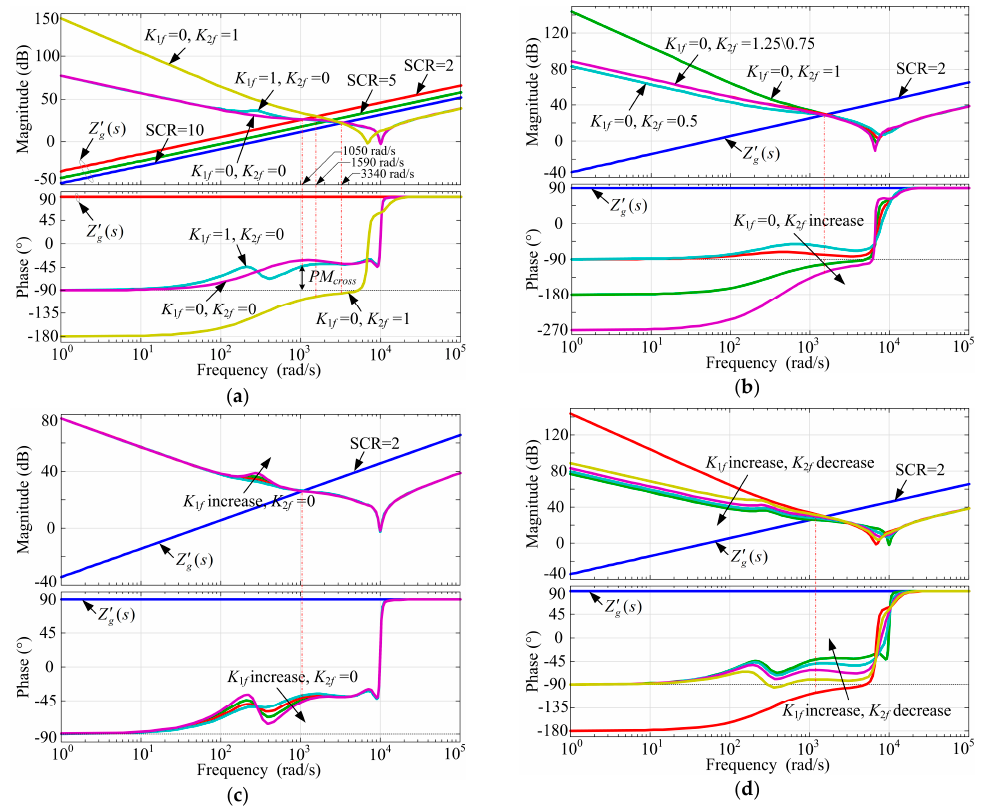
Figure 9. Bode diagrams of converter output impedance. ( a ) K 1 f = K 2 f = 0; K 1 f = 0, K 2 f = 1; K 1 f = 1, K 2 f = 0; ( b ) K 1 f = 0, K 2 f changed; ( c ) K 2 f = 0, K 1 f changed; ( d ) Both K 1 f and K 2 f are changed, and K 1 f + K 2 f = 1.